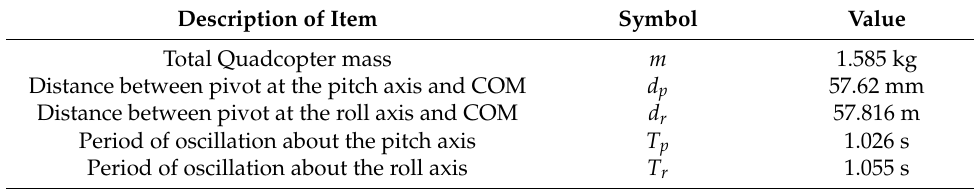
Figure 10. Location of the quadcopter’s center of mass. Table 3. Results from experimentation used to determine the moments of inertia. Description of